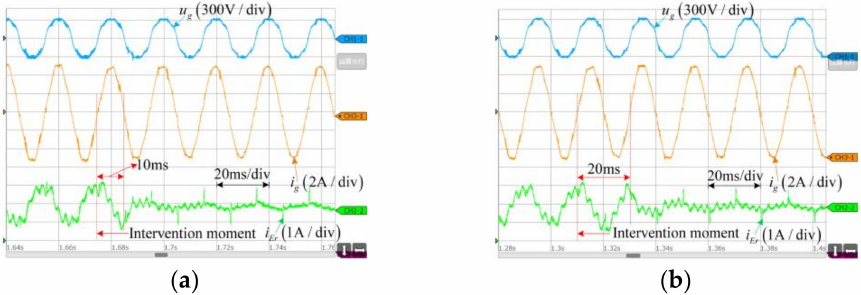
Figure 18. Experimental dynamic waveforms of two controllers. ( a ) OMRC, ( b ) standard